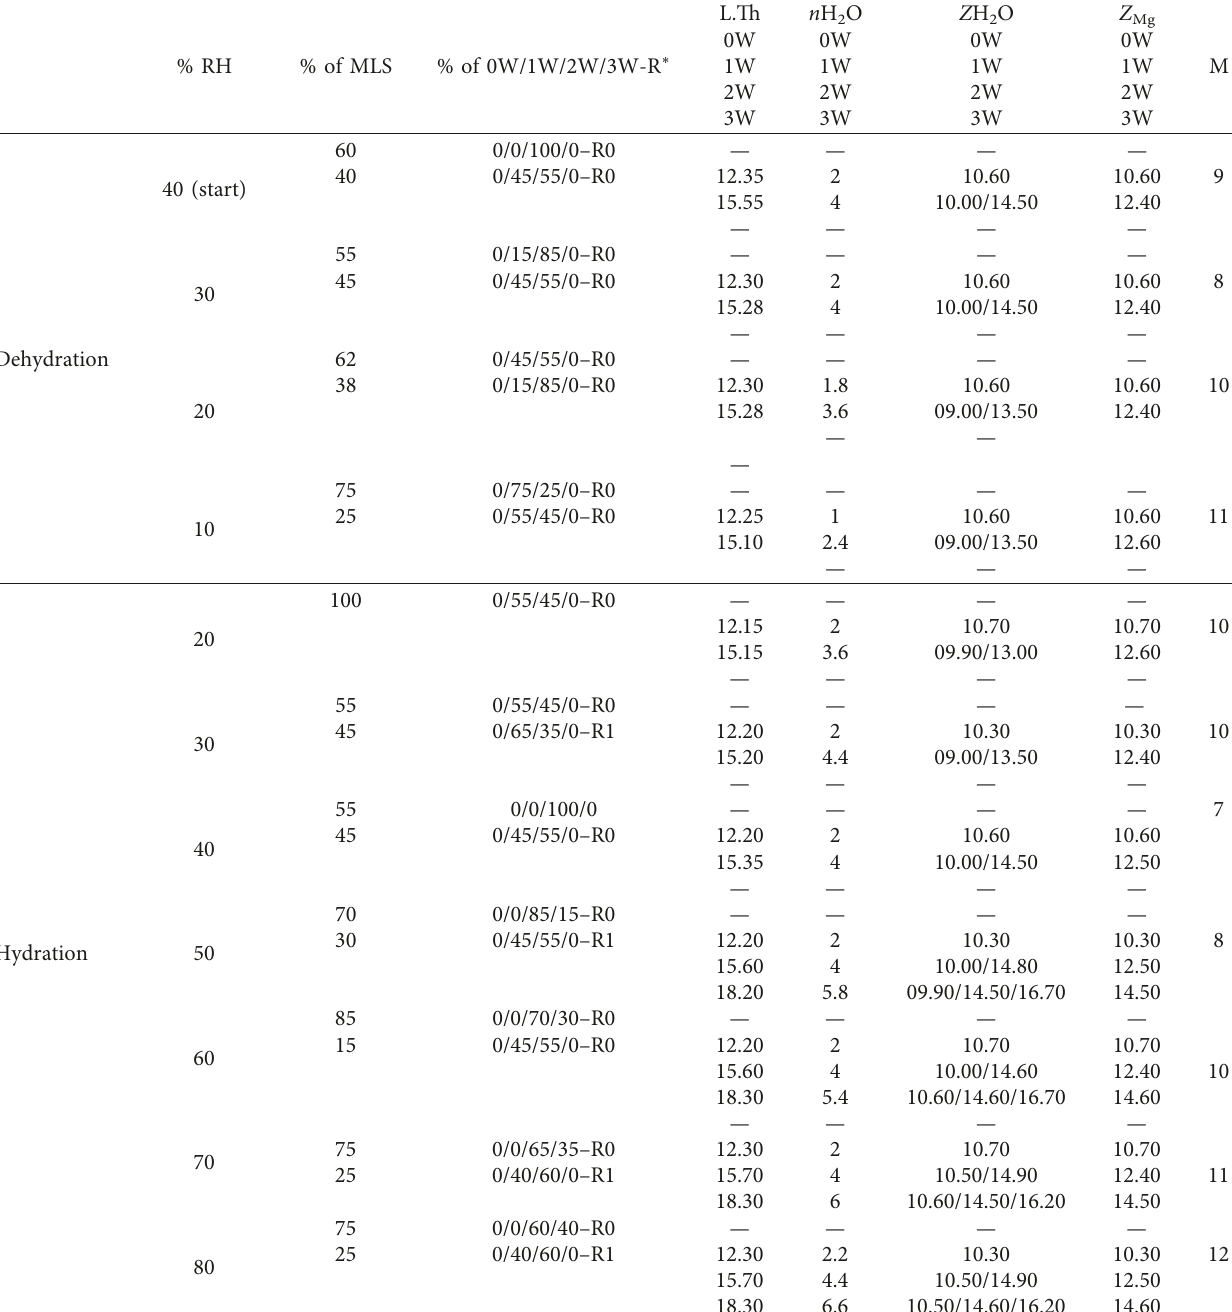
Table 4: Structural parameters used to fit experimental patterns of SWy-2-Mg complex as a function of RH along the second hydration- dehydration cycle.